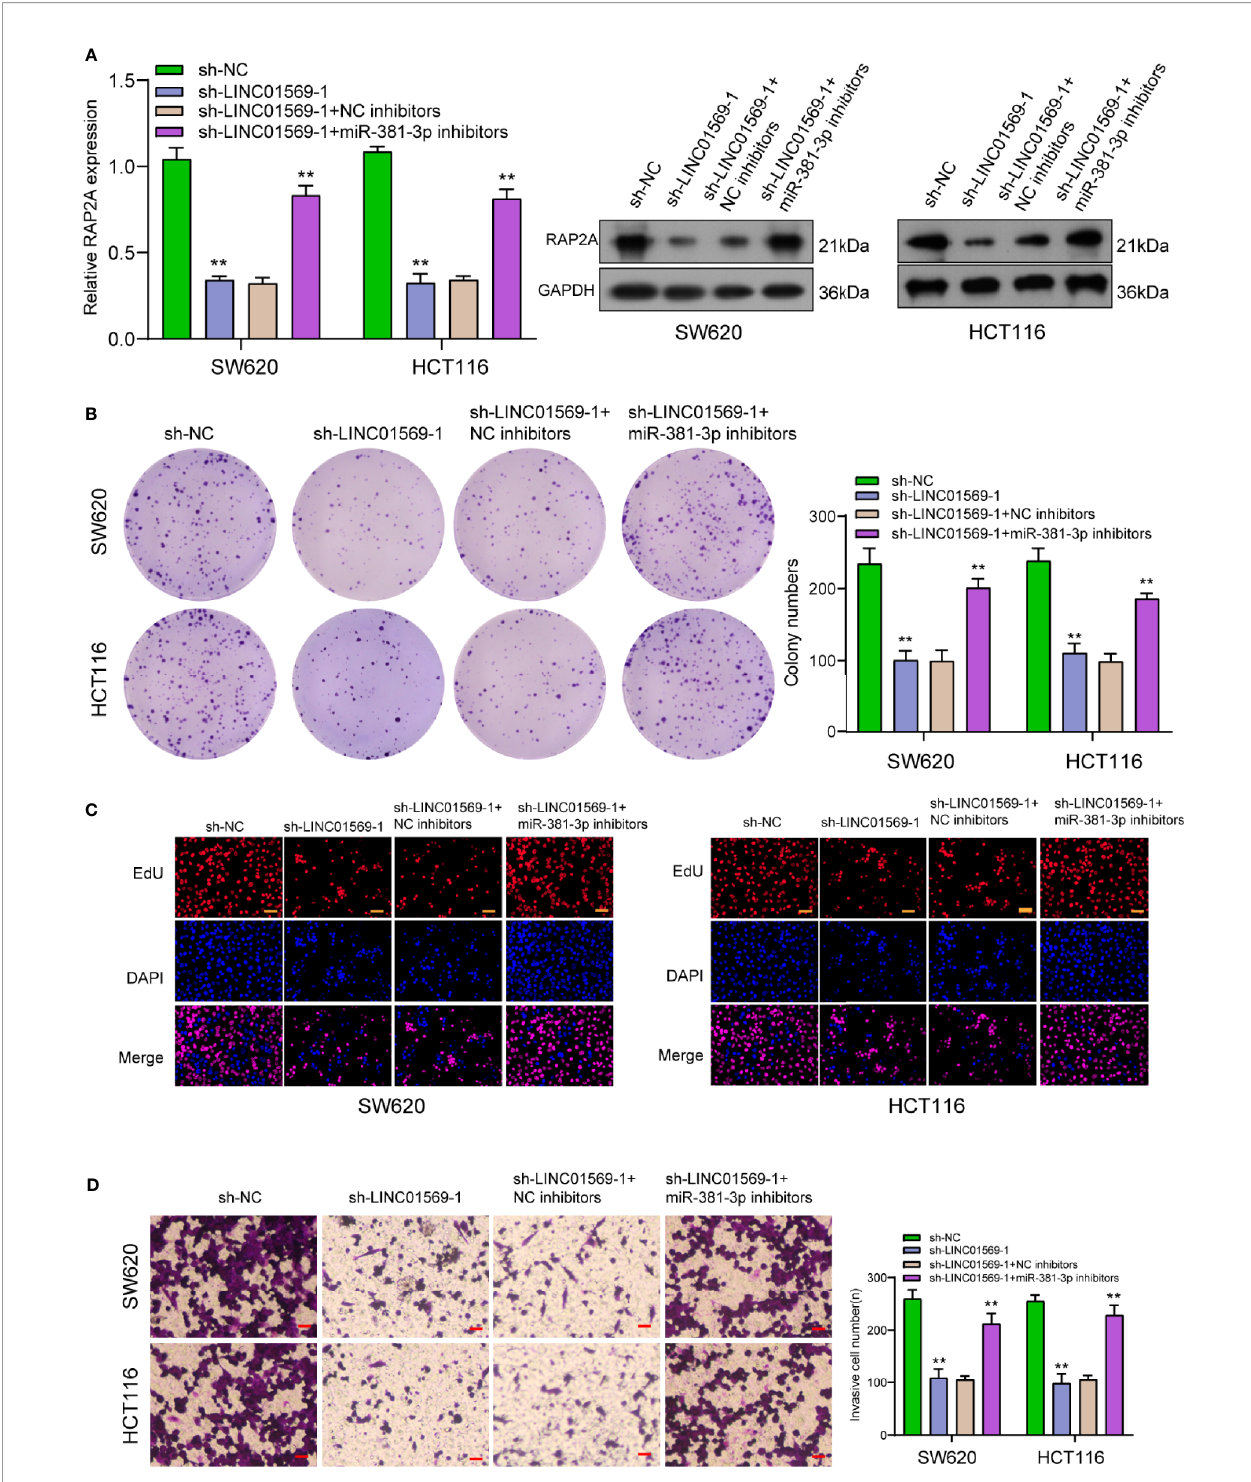
FIGURE 6 | Downregulation of miR-381-3p rescued LINC01569-induced changes in CRC cell lines. (A) RT-PCR and Western blot determined the expression of RAP2A in SW620 and HCT116 cells transfected with sh-NC, sh-LINC01569-1, sh-LINC01569-1 + NC inhibitors or sh-LINC01569-1 + miR-381-3p inhibitors. (B – D) A series of functional assays in SW620 and HCT116 cells transfected with sh-NC, sh-LINC01569-1, sh-LINC01569-1 + NC inhibitors or sh-LINC01569-1 + miR-381-3p inhibitors. **P <